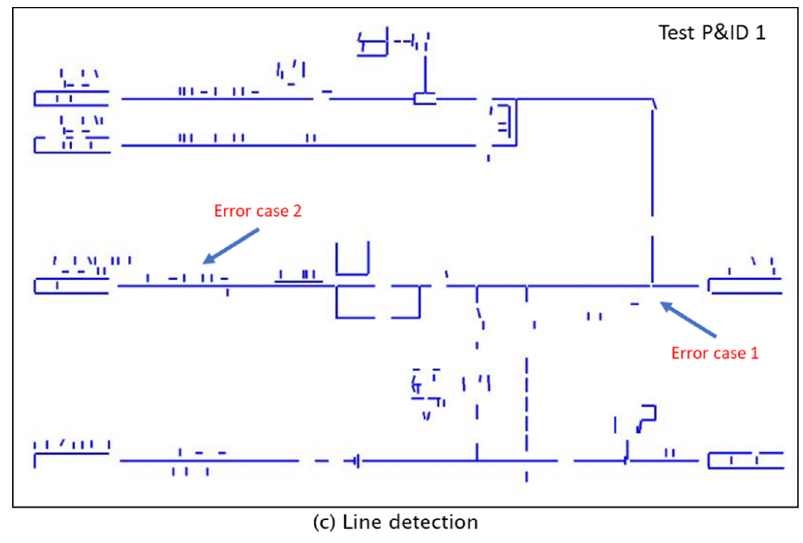
Figure 13. Recognition results of test P&IDs 1 and 2.